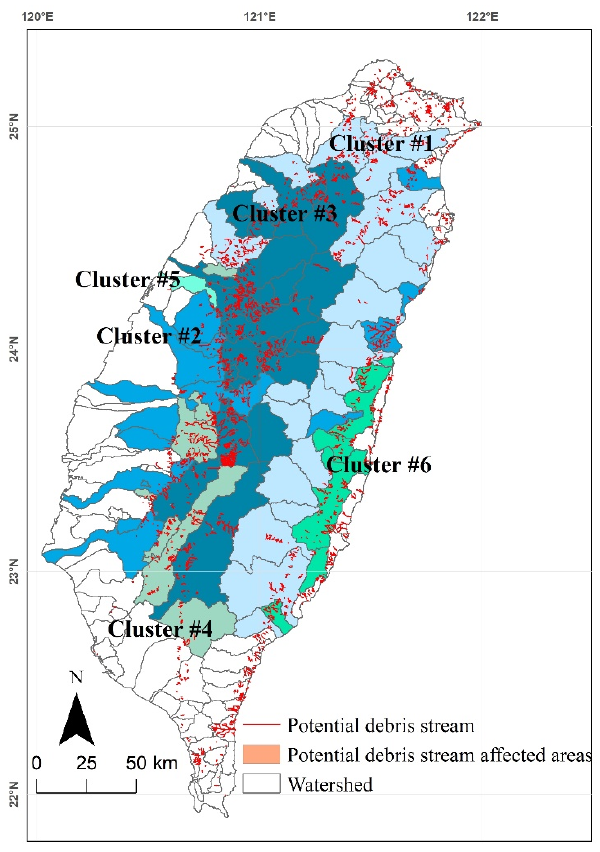
Figure 5. Spatial distribution of potential debris stream and affected areas.